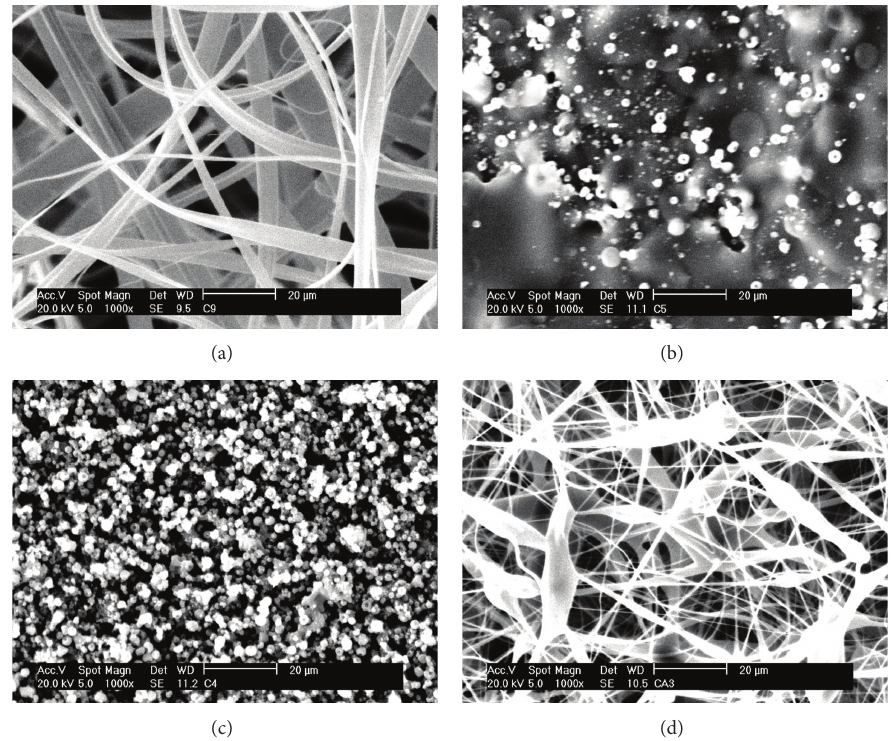
Figure 2: SEM micrographs showing the effect of individual and binary solvent systems on resulting CA electrospun fibre morphology. Mag 1000x–3000x (a) acetone; (b) DMAc; (c) acetic acid :DMAc (3:1), and (d) acetic acid :acetone